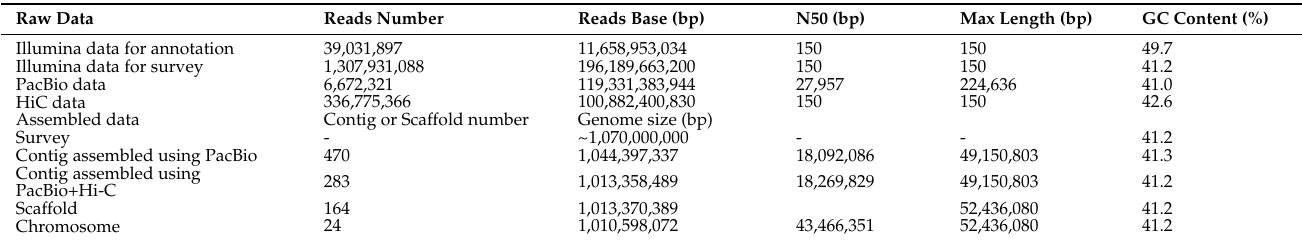
Table 1. The statistics of sequencing and assembled information of humpback grouper genome. Raw